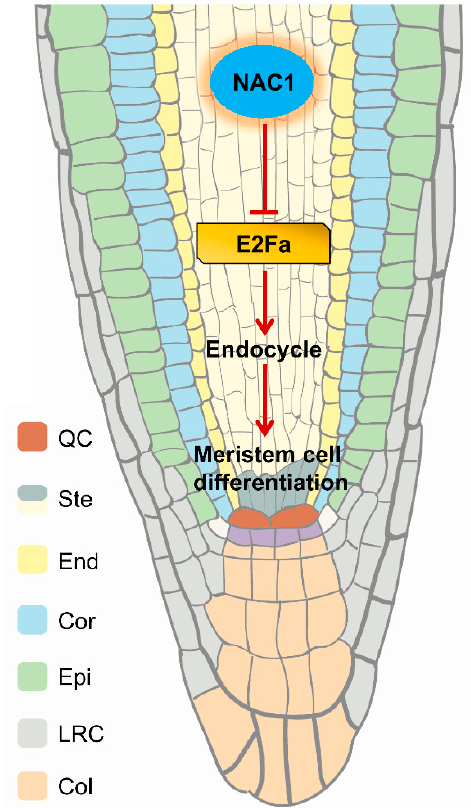
Figure 6. Hypothetical model for the regulation of primary root development by NAC1. NAC1 plays a critical role in primary root growth by directly binding to the promoter and thus repressing the transcription of E2Fa . Loss of NAC1 triggers the up-regulation of E2Fa expression, which affects root meristem cell differentiation through the regulation of endocycle.